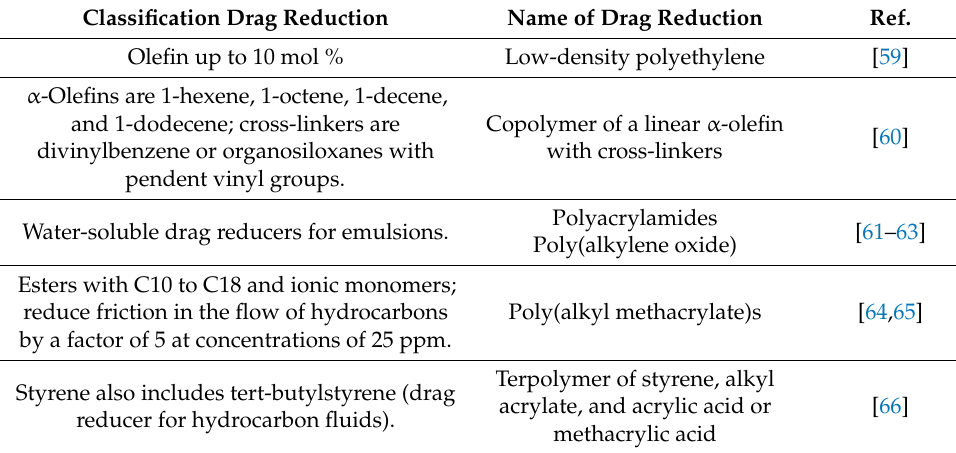
Table 2. Classification of drag reducer